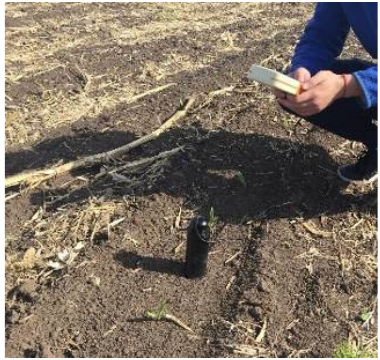
Figure 7. Measurements of soil moisture content at the seeding